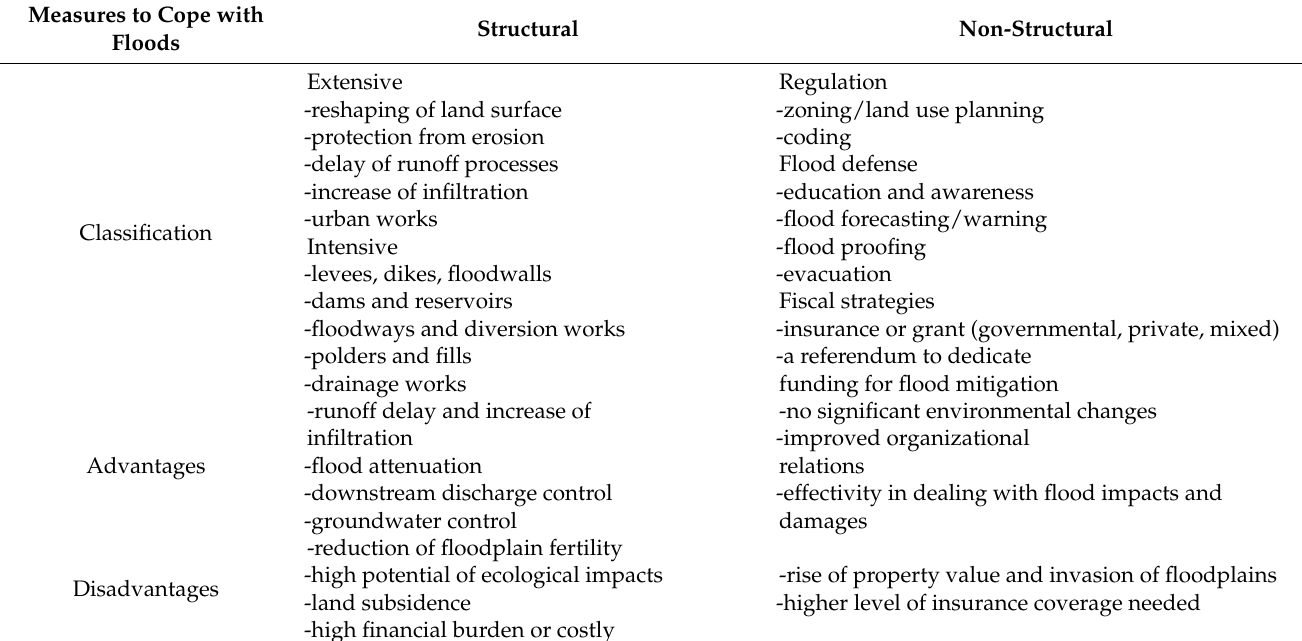
Table 2. Overview of structural and non-structural measures to cope with floods: classification [28]. Measures to Cope